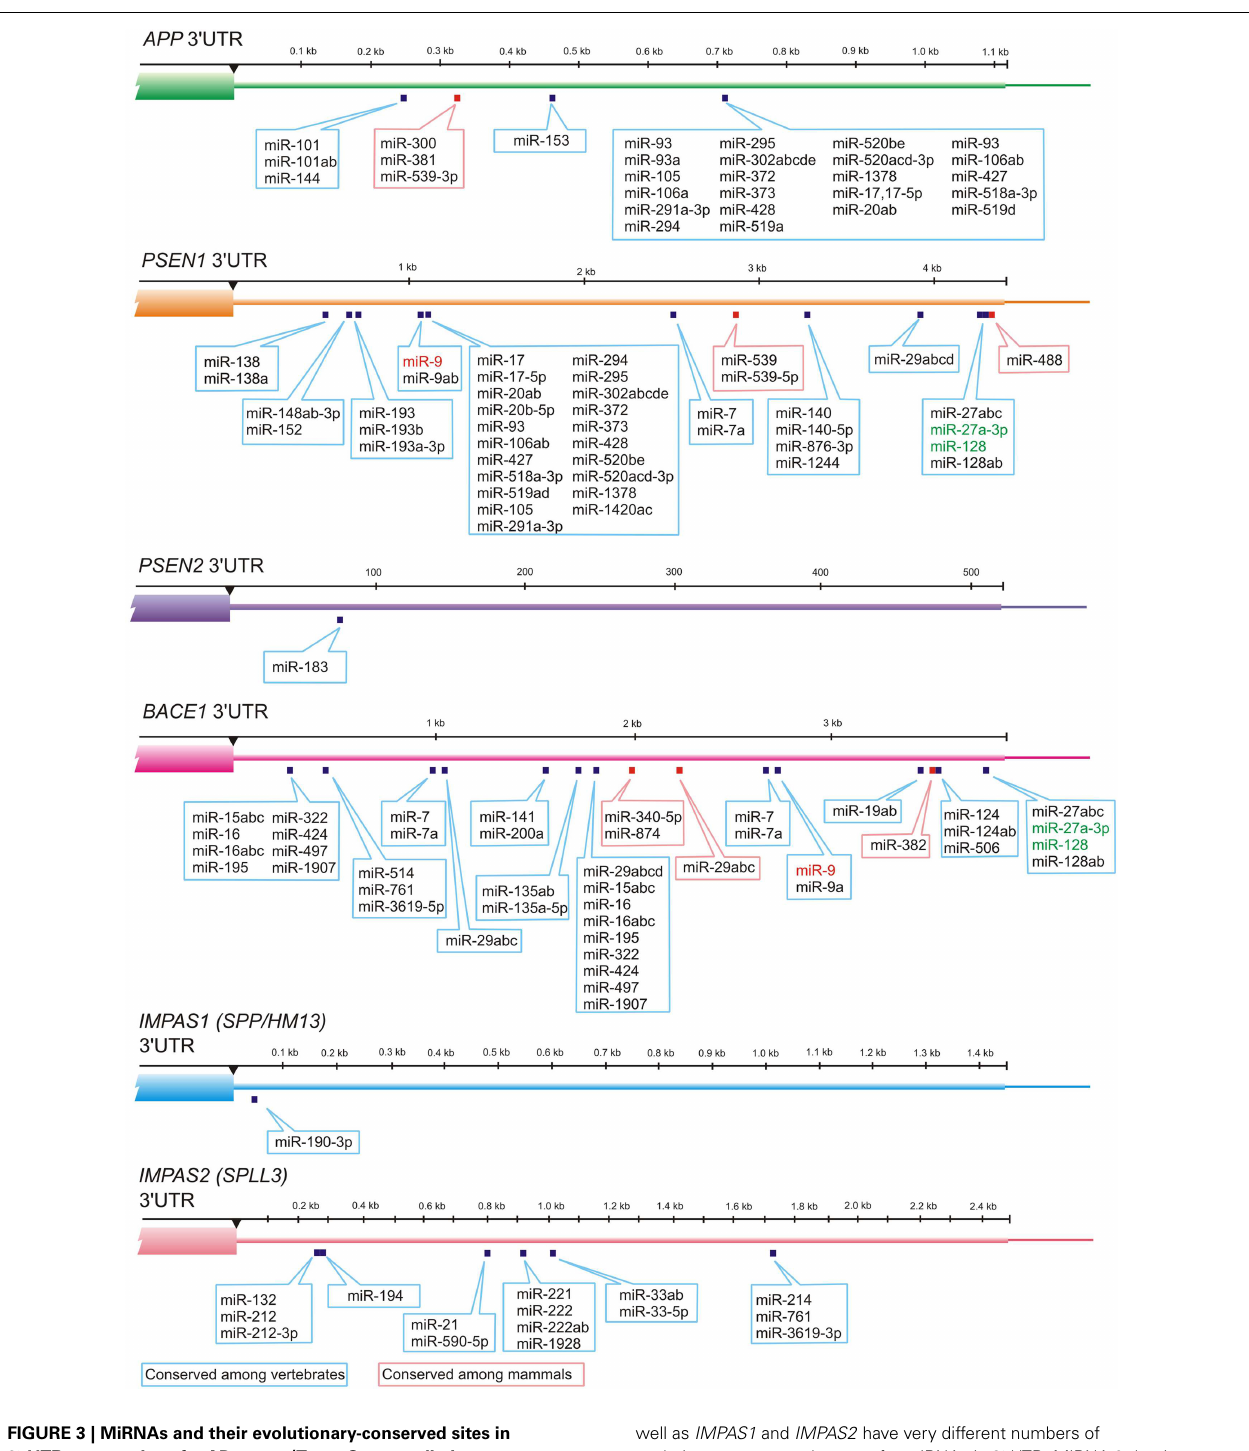
FIGURE 3 | MiRNAs and their evolutionary-conserved sites in 3 (cid:48) -UTR-gene regions forAD genes (TargetScan prediction, http://www.targetscan.org). Presenilin 1 ( PSEN1 ) and Presenilin 2 ( PSEN2 ) cleaveType I transmembrane proteins (including APP), whereas their distant structural homologs IMPAS1/SPP or other IMPAS/SPPL proteases cleaveType II transmembrane proteins. Interestingly, redundant PSEN1 and PSEN2 as